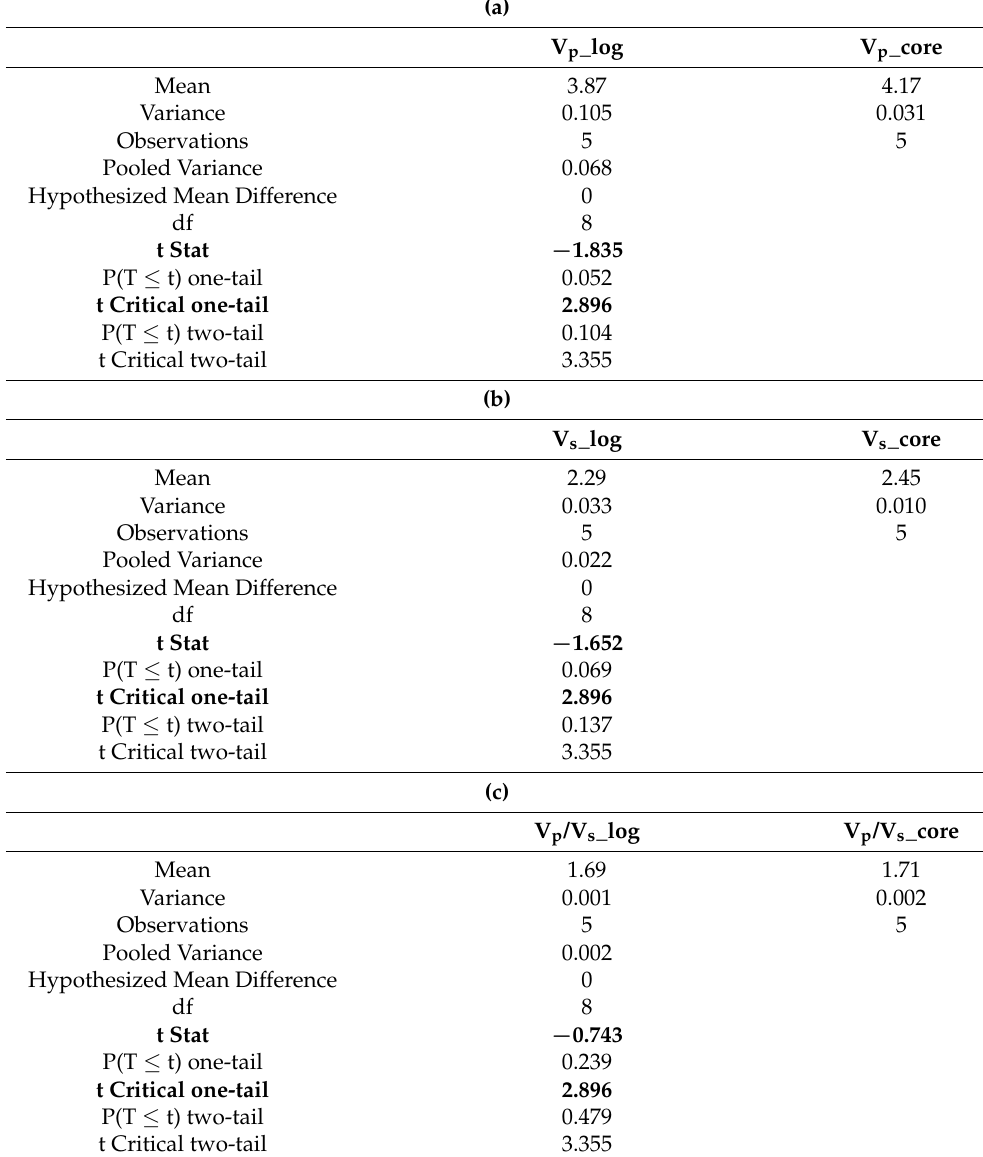
Table 6. (a) Student t -test for the co-located sonic log and ultrasonic core P-wave velocity measure- ments (after fluid substitution to in situ saturations) in the Wolfcamp formation, Midland basin. The result indicates there is no significant difference between the mean of the sonic log and ultrasonic core measurements. (b) Student t -test for the co-located sonic log and ultrasonic core S-wave velocity measurements (after fluid substitution to in situ saturations) in the Wolfcamp formation, Midland basin. The result indicates there is no significant difference between the mean of the sonic log and ultrasonic core measurements. (c) Student t -test for the co-located sonic log and ultrasonic core V p /V s ratio (after fluid substitution to in situ saturations) in the Wolfcamp formation, Midland basin. The result indicates there is no significant difference between the mean of the sonic log and ultrasonic core velocity